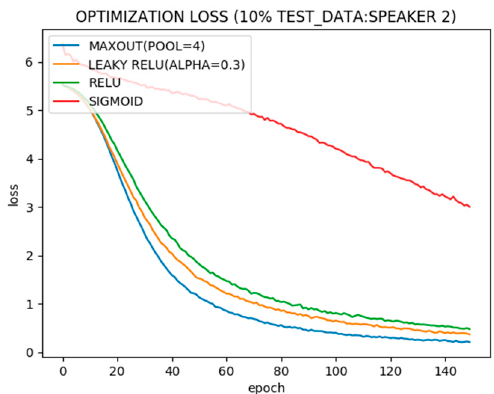
Figure 3. Training error vs. iterations for single layer activations.